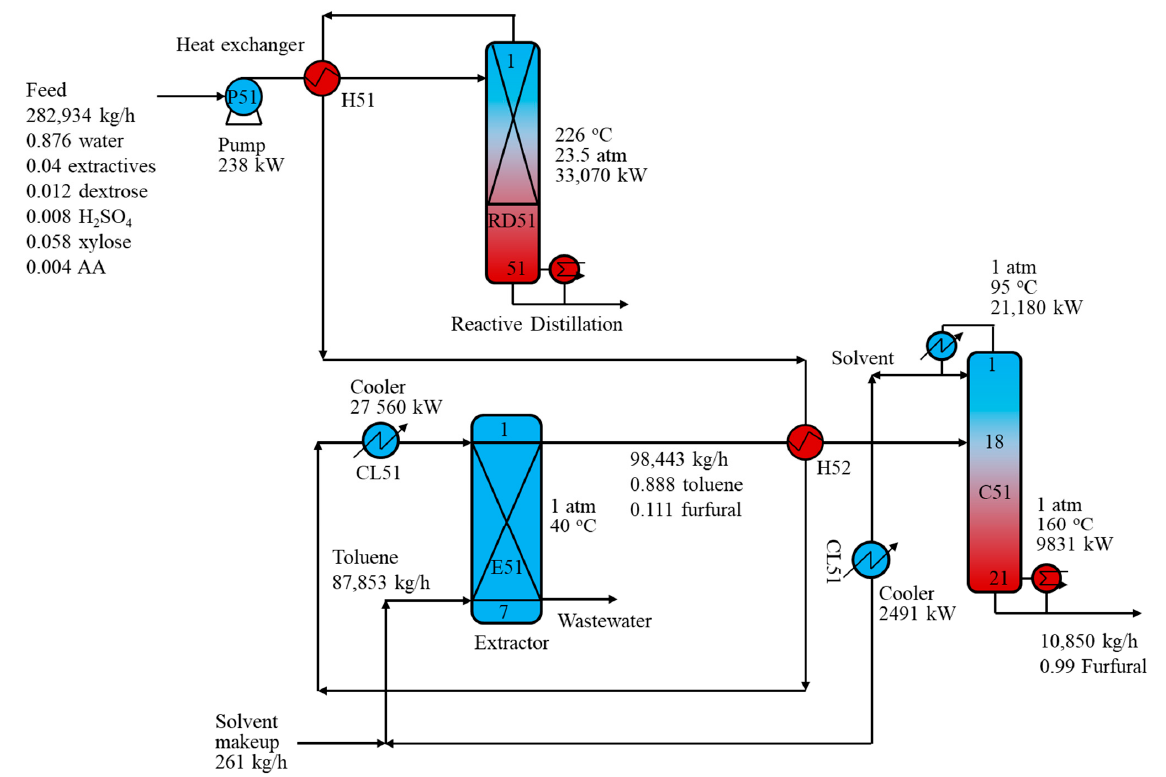
Figure 7. Schematic of the reactive distillation-distillation process with toluene solvent.